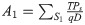
Relationship between f(s) and g(s) at simulation s = q.(a) f(q) versus g(q) and (b) Contribution of each term of the sums f(q) = A
1 + A
2(in ordinate) and g(q) = C
1 + C
2 (in abscissa). With A1=∑S1TPsqD, C1=∑S1TPsqD+∑S0FPs+∑S2FPs, A2=∑S2TPsqD+qFPs and C2=∑S2TPsqD+∑S0FPs+∑S2FPs.